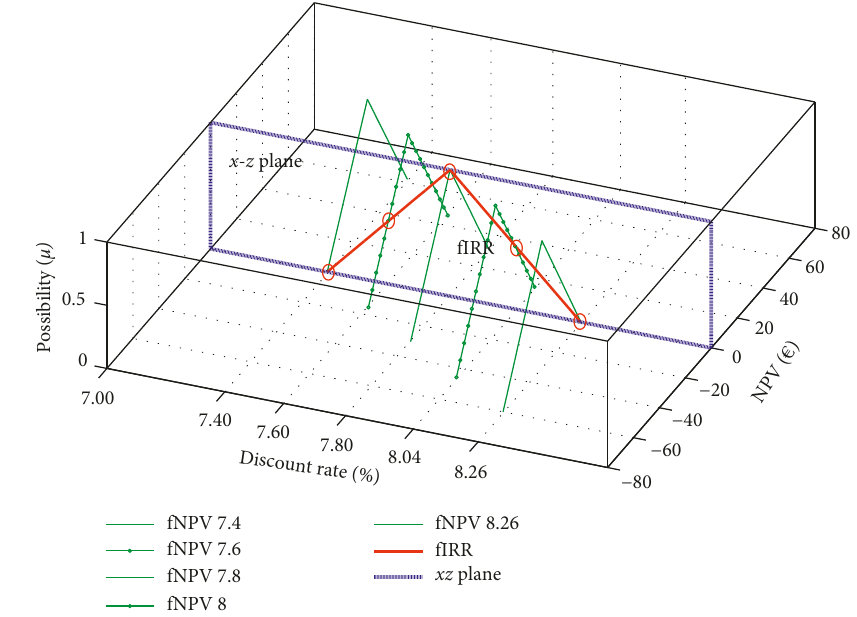
Figure 2: Definition and calculation of fIRR.